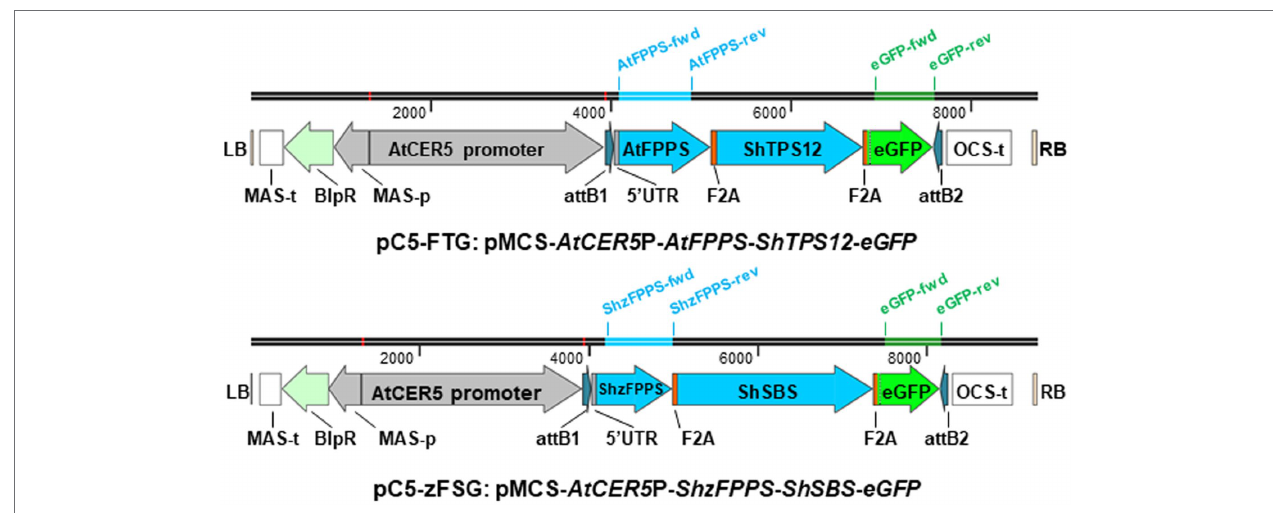
FIGURE 1 | Schematic representation of multicistronic expression constructs for epidermis-specific engineering of sesquiterpene formation. Two expression constructs were designed within the T-DNA, indicated by the left (LB) and right (RB) borders, of the binary pMCS vector. Both synthetic expression constructs are put under the control of an AtCER5 promoter sequence and inserted between the gateway attachments sites (attB1 and attB2). Each of the multicistronic expression constructs contains the coding sequences for three proteins: a prenyl transferase (AtFPPS or ShzFPPS), a terpene synthase (ShTPS12 or ShSBS), and enhanced green fluorescent protein (eGFP). The three individual coding sequences within both multicistronic expression constructs are linked by a short nucleotide sequence encoding the self-processing foot-and-mouth disease virus 2A oligopeptide (F2A). Other elements located within the T-DNA are the octopine synthase terminator (OCS-t), mannopine synthase promoter (MAS-p), and terminator (MAS-t) and phosphinothricin acetyltransferase (BlpR). The bars above the pC5-FTG and pC5-zFSG constructs indicate their size (in base pairs) and the location of the three primer pairs used for RT-PCR analysis of AtFPPS , ShzFPPS , and eGFP